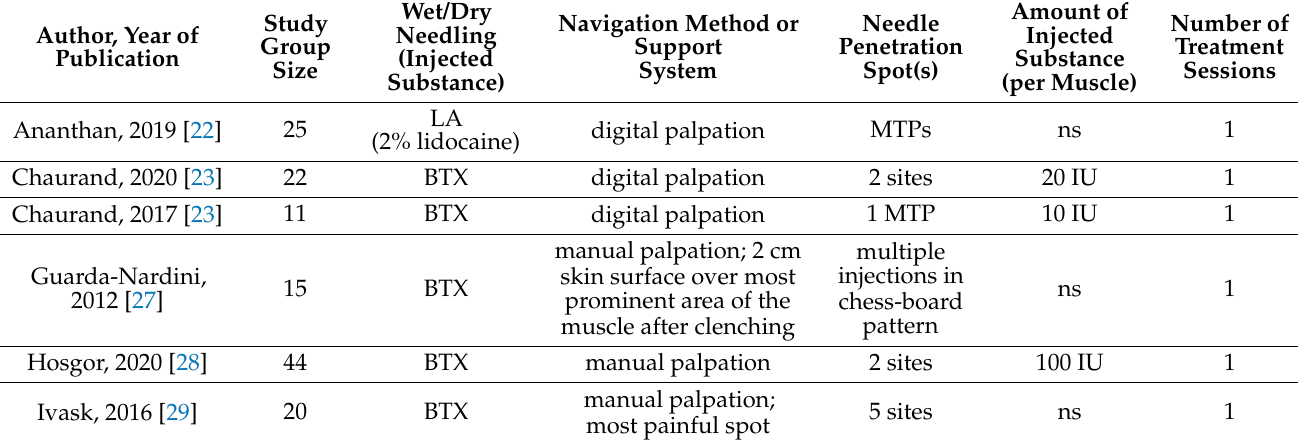
Table 4. Studies regarding temporal muscle